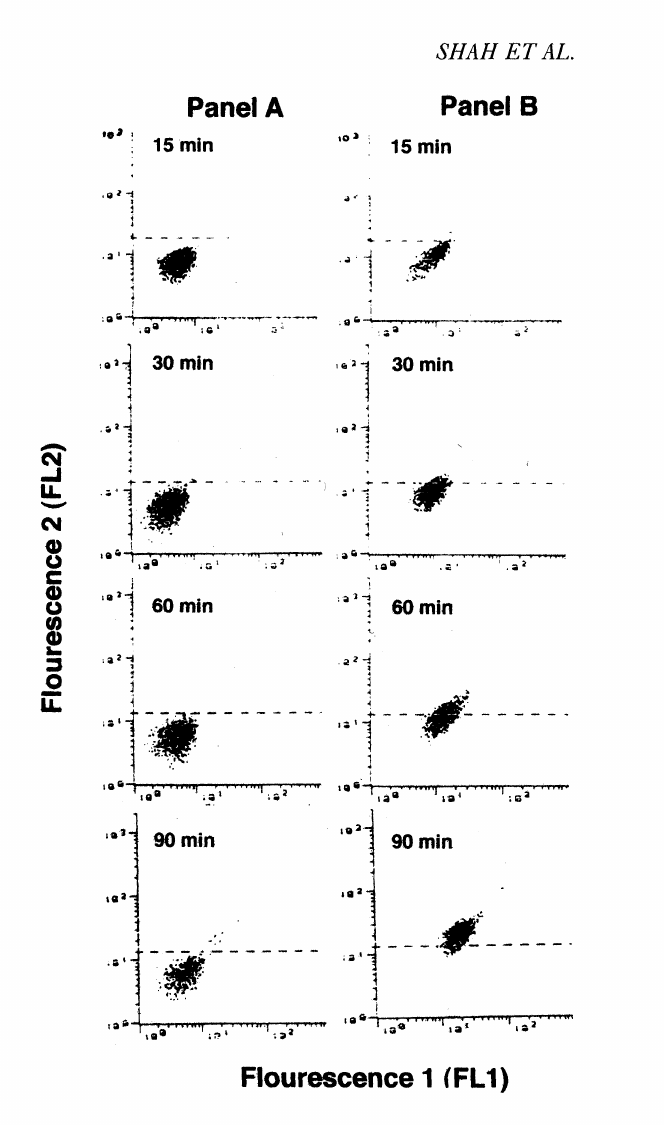
Fig. 3. Propidium iodide uptake measures by FL2 fluores- cence. FL2 fluorescence (due to PI uptake) was increased by increasing the incubation time of gliotoxin-treated (500 IJg/ mL) PMN. Panel A represents the unintoxicated PMN, which do not show significant increases in FL2 fluorescence. As the incubation time increases, more PMN are seen in the FL2 region of panel B, which reprresents gliotoxin-treated